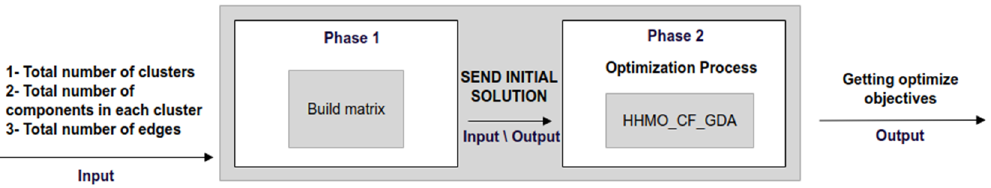
Figure 1. The framework of module clustering optimization prototype.